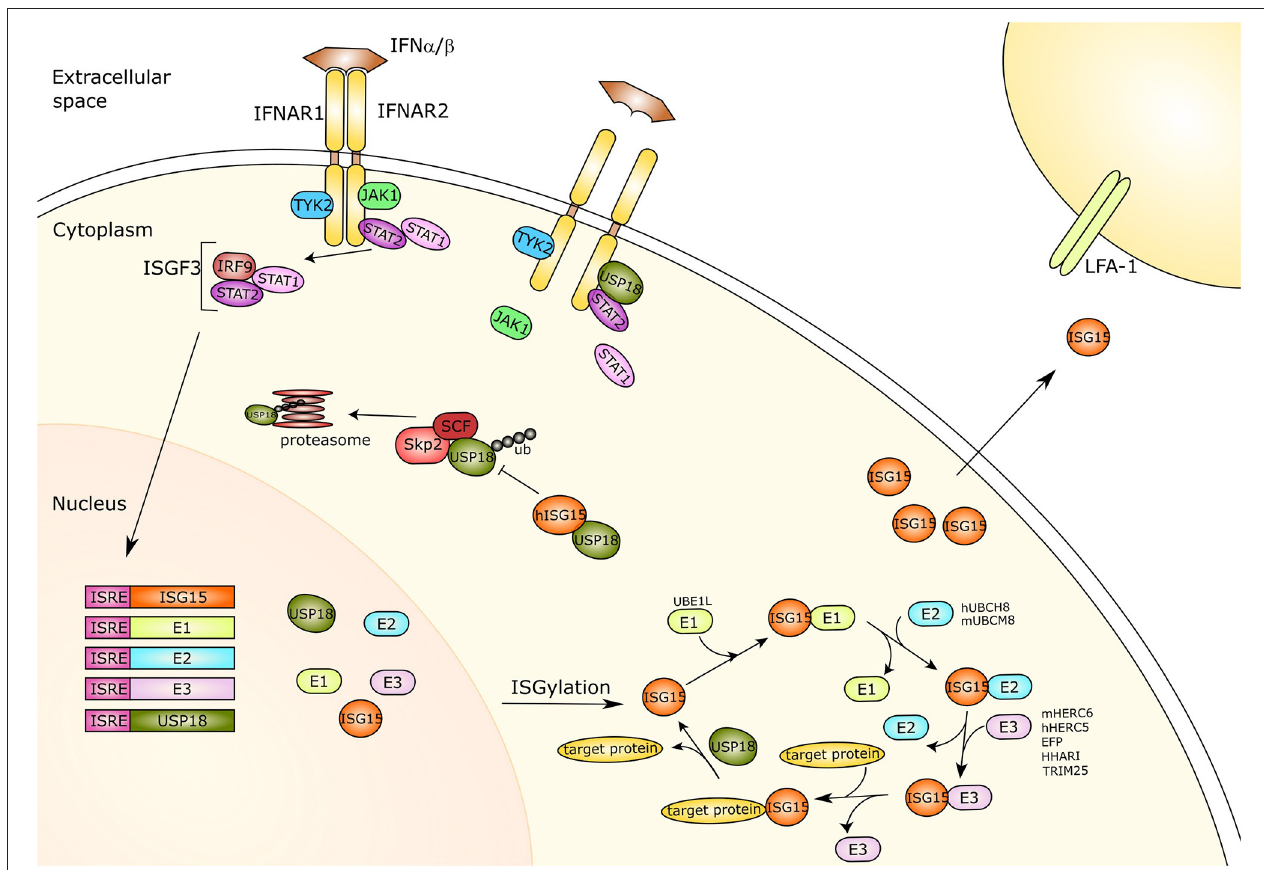
FIGURE 1 | Type-I interferon signaling and ISG15. Type I interferon (IFN) binds its receptor causing the dimerization of the two subunits IFNAR1 and IFNAR2 and thus the activation of the JAK-STAT pathway. The receptor associated kinases TYK2 and JAK1 induce recruitment and phosphorylation of STAT1 and STAT2. The phosphorylated proteins translocate to the nucleus and together with IRF9 form a trimer called ISGF3. This trimer acts as a transcriptional activator and is capable of binding to the ISRE of IFN response genes activating their expression. ISG15 and its three conjugating enzymes E1-activating enzyme (UBE1L), E2-conjugating enzyme (hUBCH8, mUBCM8) and E3 ligases (hHERC5/mHERC6, EFP, HHARI, TRIM25), as well as the ISG15 protease USP18 are all IFN-response genes. ISG15 is linked to target proteins via its conjugation system, which is counteracted by USP18 protease activity. Moreover, free ISG15 can act as a cytokine binding to LFA-1, subsequently inducing IFN- γ secretion by natural killer cells and T lymphocytes. Furthermore, USP18 also plays an important role as a negative regulator of IFN type I signaling. USP18 can interact with IFNAR2 and STAT2, competing with JAK1 for receptor binding and thus inhibiting signal transduction. The SCF Skp2 complex binds USP18 by mediating its poly-ubiquitination and proteasomal degradation, which is inhibited by ISG15 in human cells only. IFNAR, Interferon alpha/beta receptor; Tyk2, Tyrosine kinase 2; JAK1, Janus Kinase 1; STAT1/2, Signal transducer and activator of transcription 1/2; IRF9, Interferon regulatory factor 9; ISGF3, Interferon-stimulated gene factor 3; ISRE, Interferon-sensitive response element; ISG15, IFN-response gene 15; UBE1L, Ubiquitin-activating enzyme E1 homolog; h, human; hUBCH8, Ubiquitin/ISG15-conjugating enzyme E2 L6 in human; m, mouse; mUBCM8, Ubiquitin/ISG15-conjugating enzyme E2 L6 in mouse; mHERC6, E3